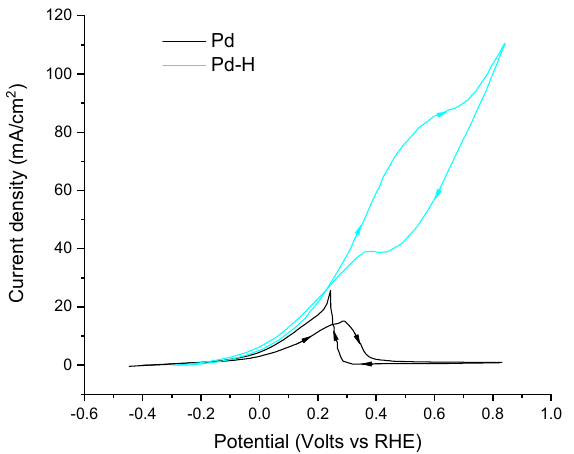
Figure 9. Comparison of Pd (black) with Pd-H (cyan) for formate oxidation in alkaline conditions, showing a significantly reduced poisoning effect for the initial Pd vs. Pd–H. Digitized from Ref. [123].